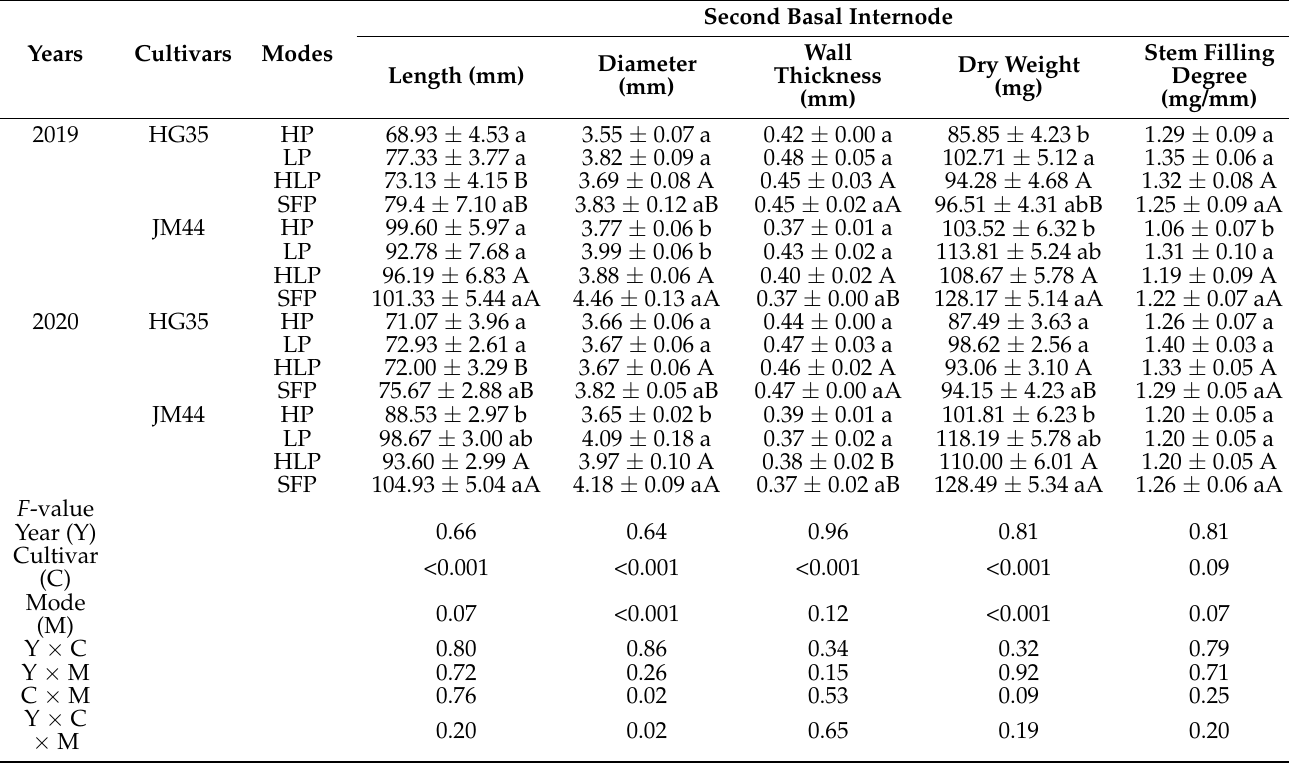
Table 3. Analysis of variance for sowing modes, cultivars, and their interactions on the morphological characteristics of culm second basal